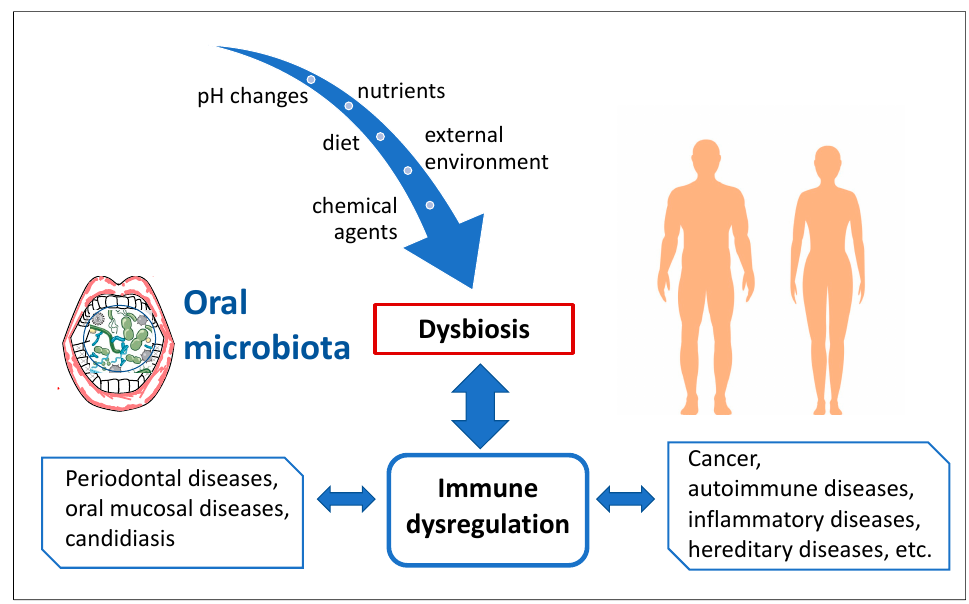
Figure 4. Relation between the immune system and microbiota in the oral cavity. The oral immune system is composed of three major compartments: the epithelial layer, lamina propria and the mucosal-associated lymphoid tissue (MALT). The cells of the